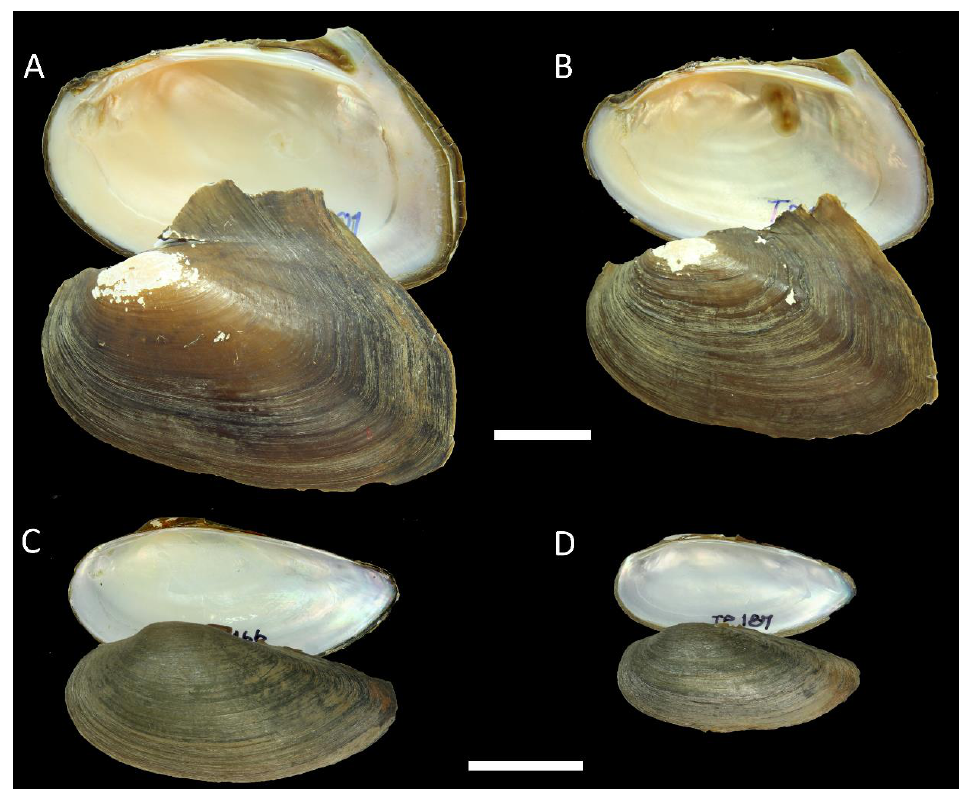
Figure 6. Shells of Hyriopsis and Ensidens (Rectidentini) members from Southern Thailand. ( A ) Hyri- opsis myersiana (Lea, 1856), specimen RMBH biv 1270/1, Main Klong Sok River, Surat Thani Province; ( B ) H. myersiana , specimen RMBH biv 1271/1, the same river; ( C ) Ensidens ingallsianus (Lea, 1852), specimen RMBH biv 1285/1, Old Main Tapi River, Surat Thani Province; ( D ) E. ingallsianus , specimen RMBH biv 1292/2, Klong Bang Kian Sa River, Surat Thani Province. Scale bars = 20 mm. Photos: Ekaterina S. Konopleva.